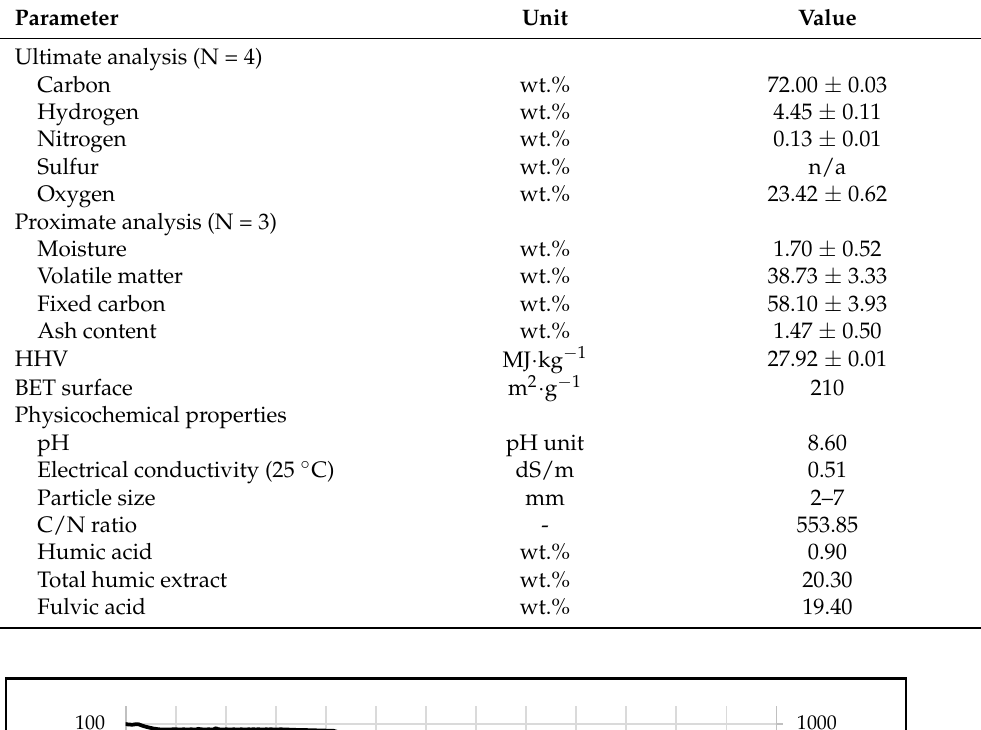
Table 2. Composition and characteristics of Pinus pinaster biochar. HHV = High Heating Value.